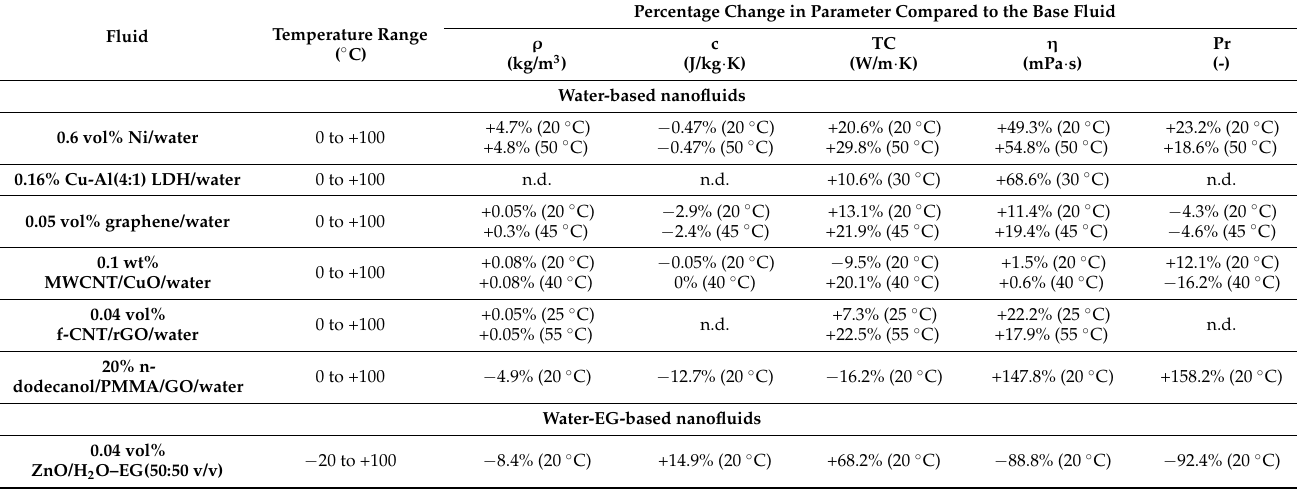
Table 4. Percentage change in thermophysical and physicochemical properties of selected nanofluids compared to the base fluid. Fluid